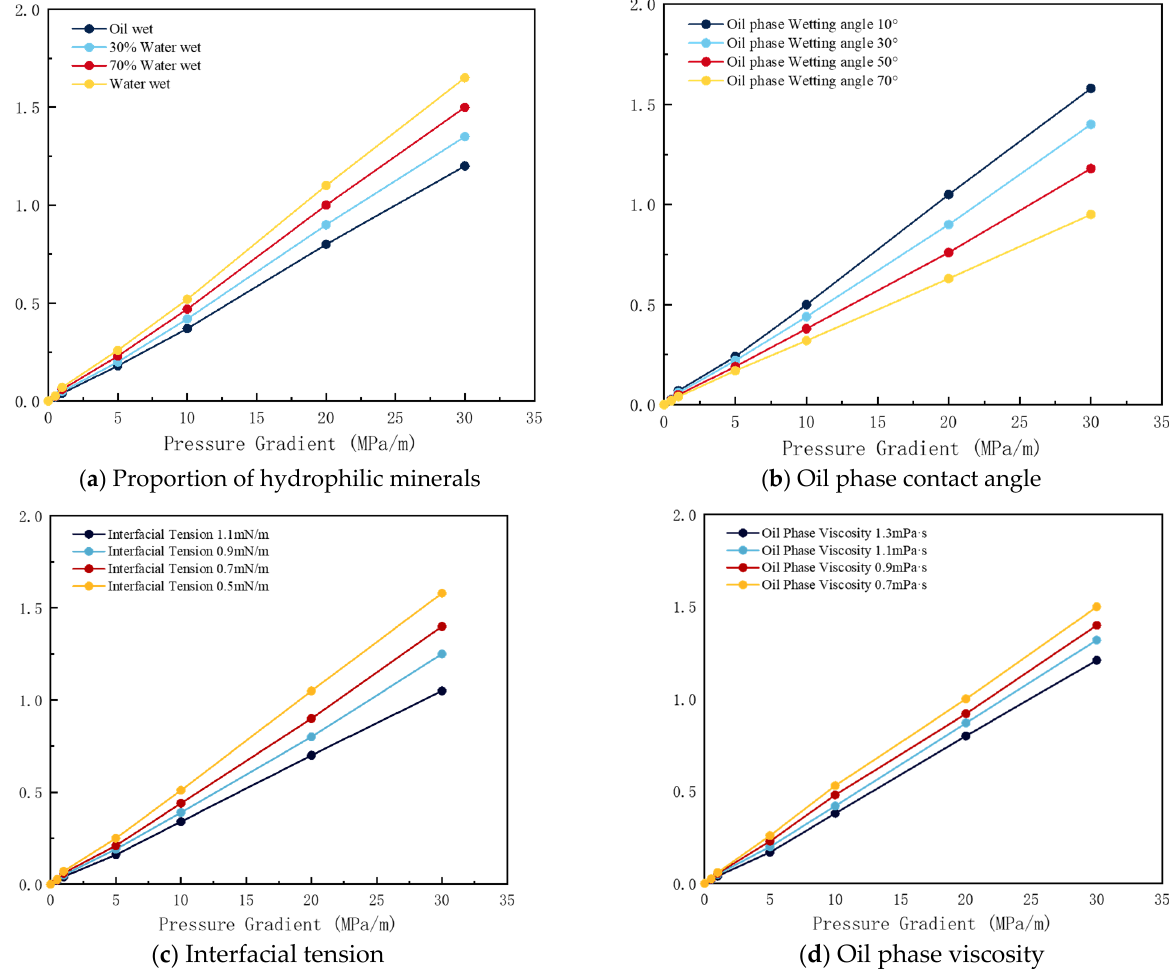
Figure 24. Relationship curve between oil phase flow rate and pressure gradient under different Figure 24. conditions.